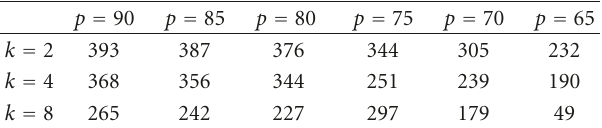
Table 1: Threshold setting for di ff erent conditions under the 0.3 dB of visual quality degradation.